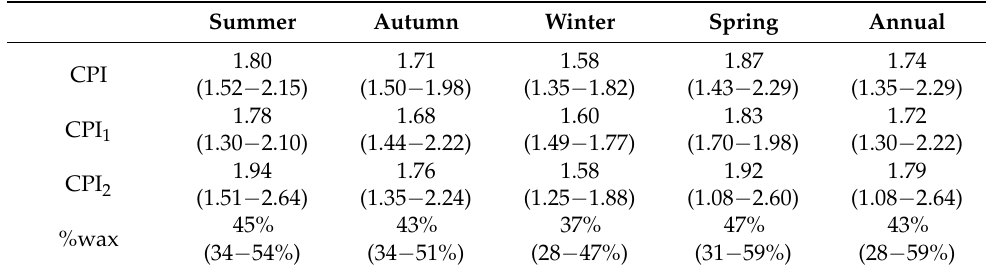
Table 3. CPI and %wax values of PM 2.5 -bound alkanes at